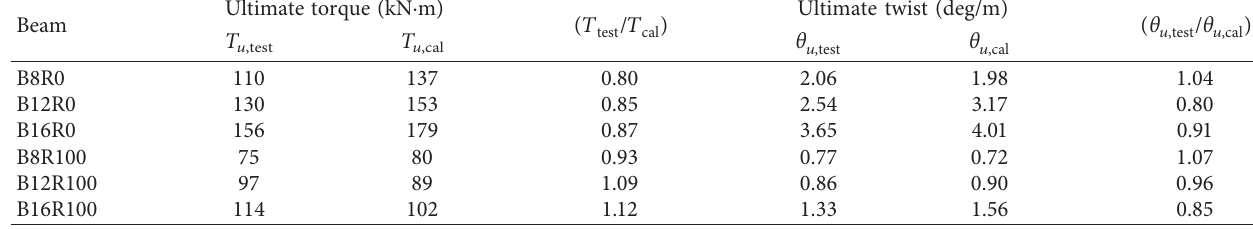
Table 4: Experimental and theoretical results from equation (18).